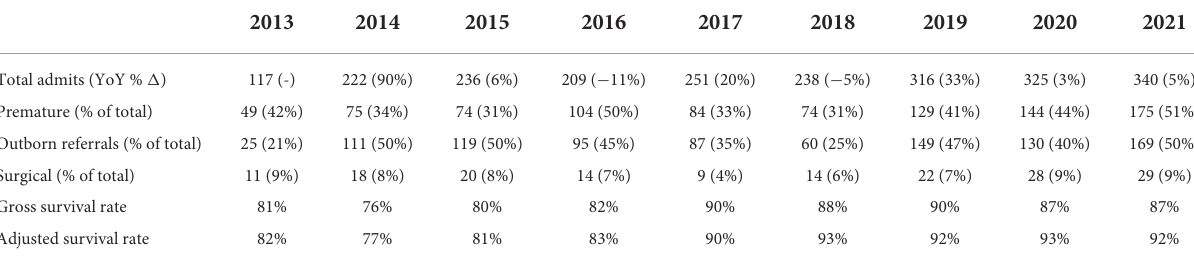
TABLE 1 NICU total admissions, prematurity, referrals, surgical admissions, and adjusted survival by year from 2013 to 2021.